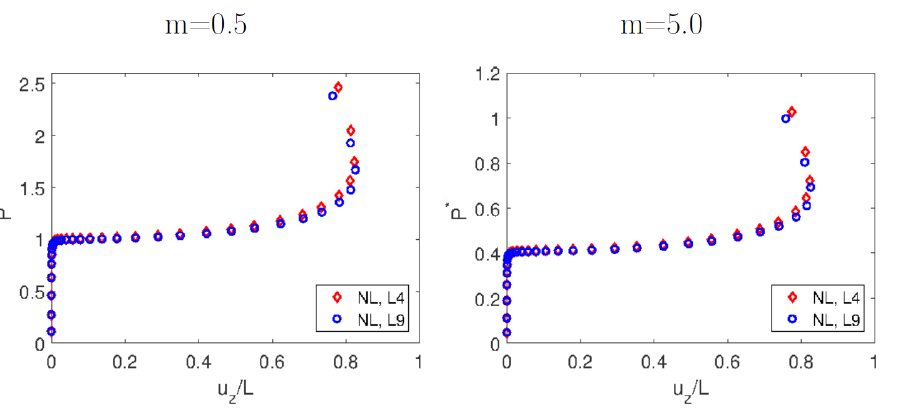
Figure 10. The equilibrium curves for L4 and L9 of single-cell FG beam subjected to axial loading, P ∗ = 4 PL 2 / π 2 EI